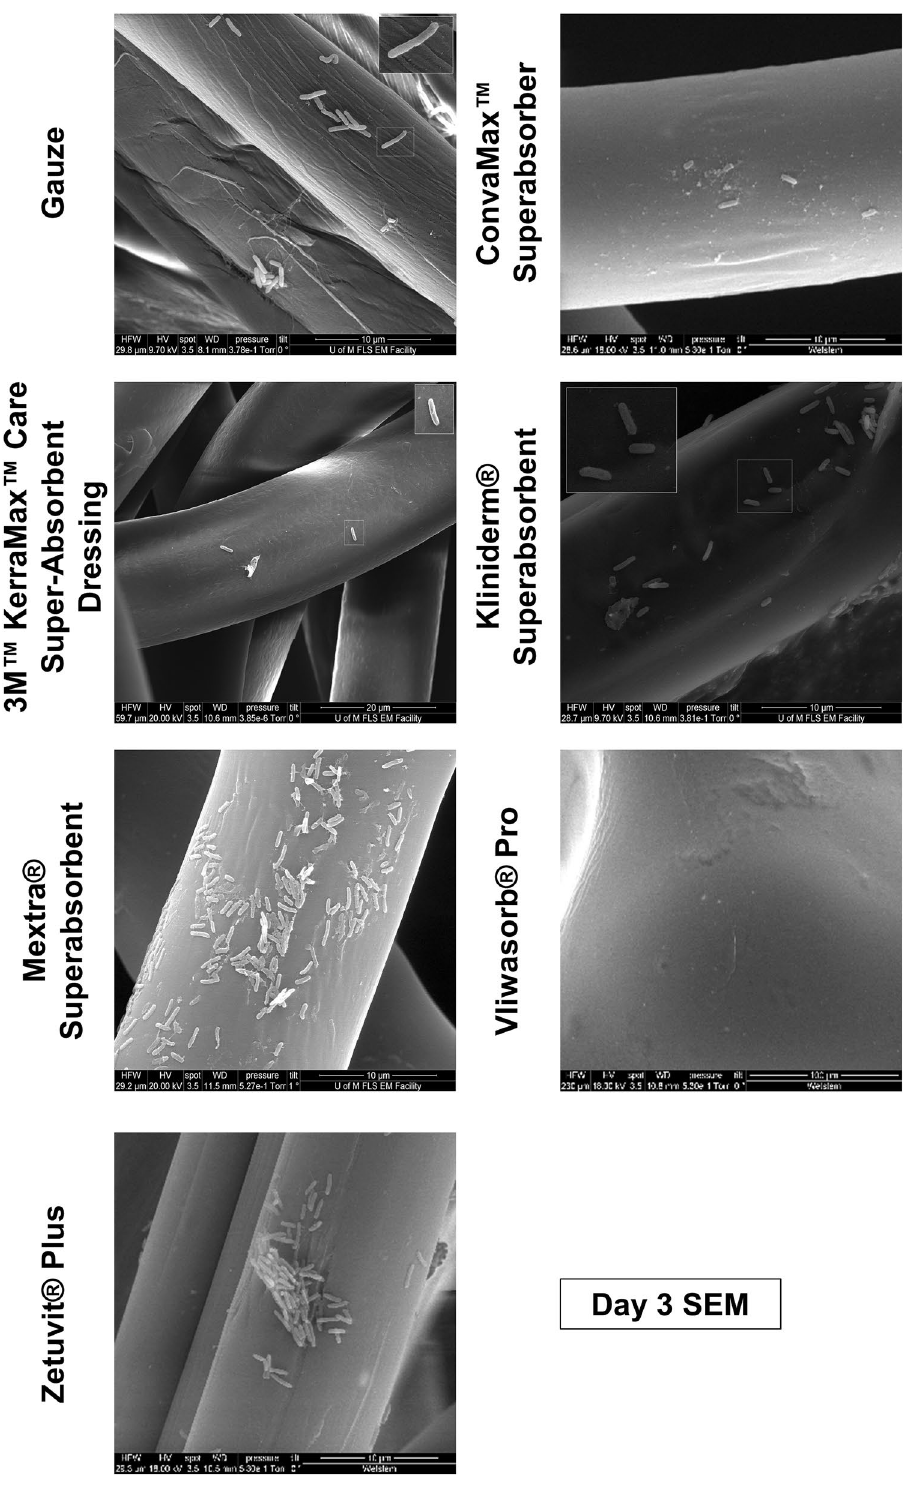
Figure 8. Localisation of P. aeruginosa within the outer layer of superabsorbent dressings at day 3. Superabsorbent wound dressings were inoculated daily with 1 * 10 7 CFU/ml of either Pseudomonas aeruginosa daily, over 7 days in triplicate. On 1, 3 and 7 days of inoculation, the outer membrane of each dressing was removed and fixed in glutaraldehyde, before being critical point dried, painted with conductive silver and sputter coated. Representative images of the outer membrane for dressings inoculated for 3 days with P. aeruginosa , are shown. Figure produced in Microsoft PowerPoint